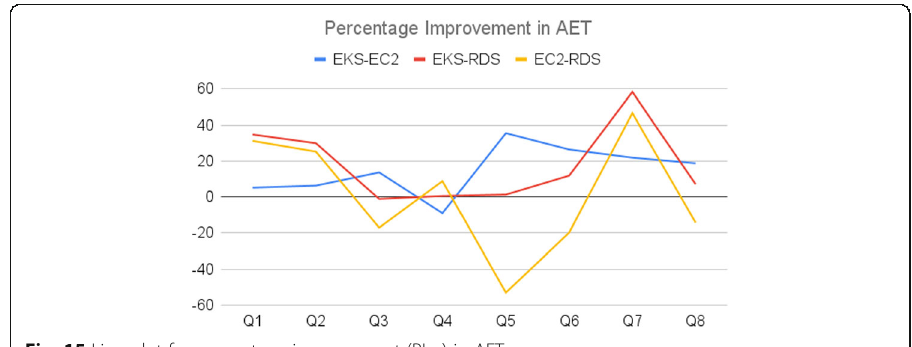
Fig. 15 Line plot for percentage improvement (PI AB ) in AET